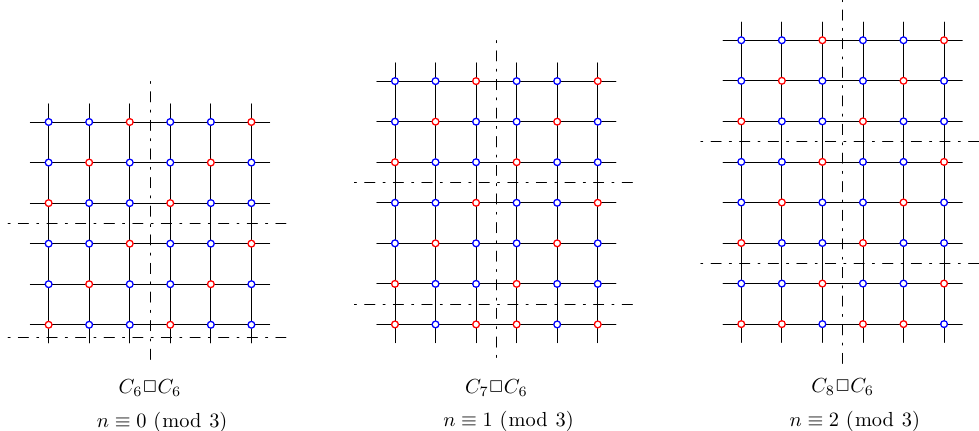
Figure 2. f on C n 2 C m for m 0 ( mod3 ) . Above the last horizontal dashed line, the block separated by the dashed lines is C 3 2 C 3 under g .